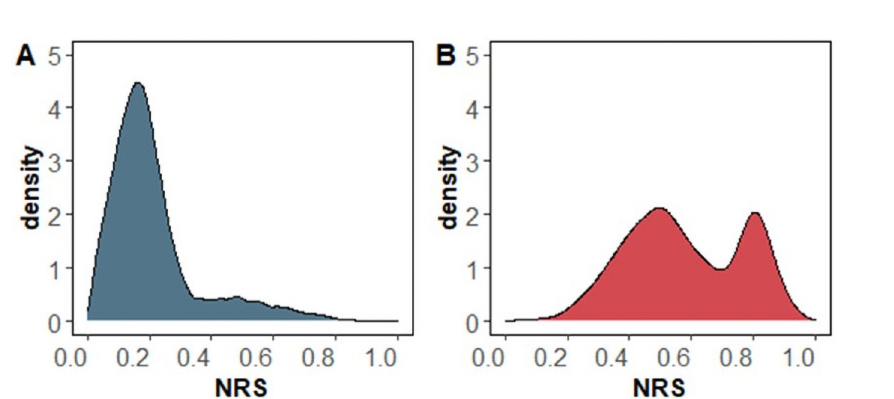
Fig 3. Examples of NRS distributions. The cell NRS is plotted for an (A) LN0 and (B) LN+ patient.